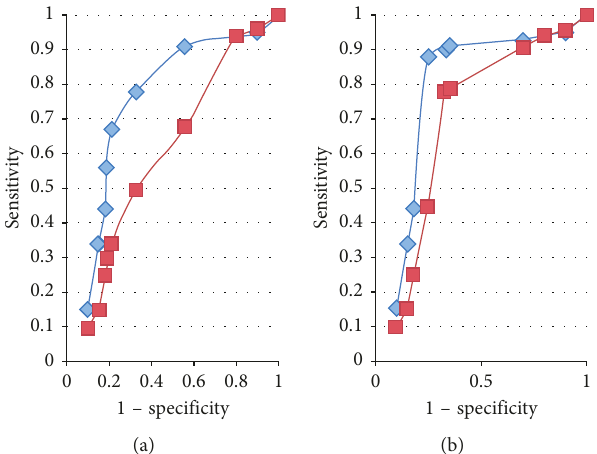
Figure 1: ROC curves corresponding to the sensitivity and specificity of possible cutoff points for discriminating children with asthma (control and uncontrol) and without it (a) and for discriminating children with controlled and uncontrolled asthma (b).